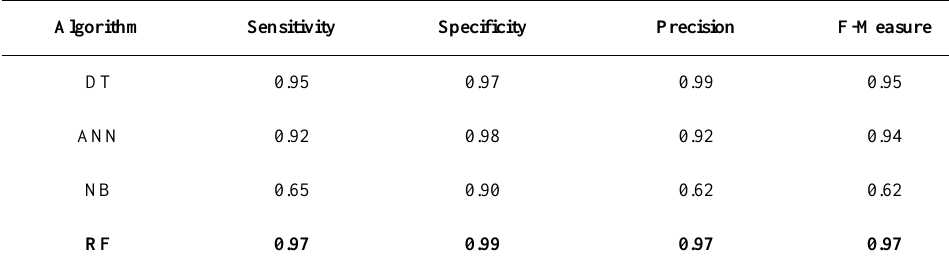
Table 4. Statistics of four ML